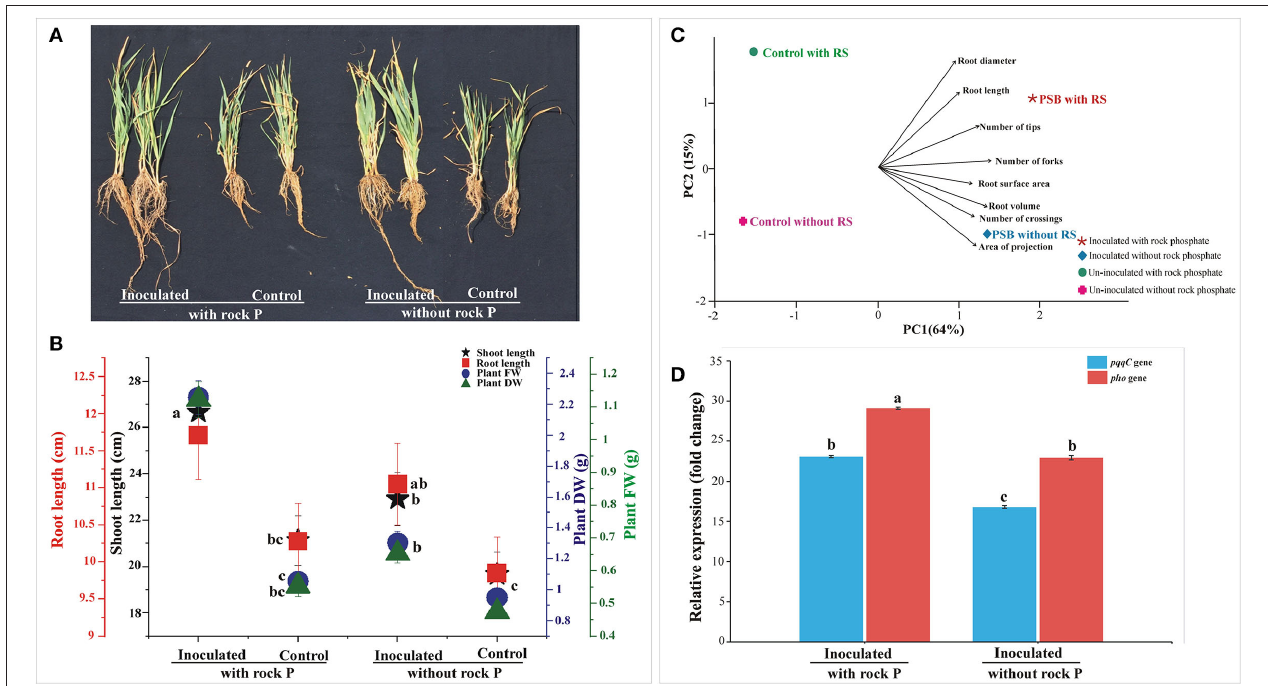
FIGURE 2 | In vivo Screening of PSB inoculation in soil amended with RP and analysis of bacterial gene expression. The data was recorded at 30 days of cultivation. Plants were used to evaluate different plant growth parameters (A,B) and root parameters (C) . Principal component analysis linking SSR inoculation to wheat root architecture (C) . The components elucidate a total variance of 79%. The loadings showed strength and direction of root parameters in dataset. The relative expression profile of pqqC and pho encoding gene of Ochrobactrum sp. SSR, expressed in the soil of the different treatments (D) . The data represents the relative fold changes in the expression values of the pqqC and phosphatase gene of Ochrobactrum sp. SSR in the soil with respect to gcd gene. Bars with distinct alphabetical letters are significantly different at p ≤ 0.05.